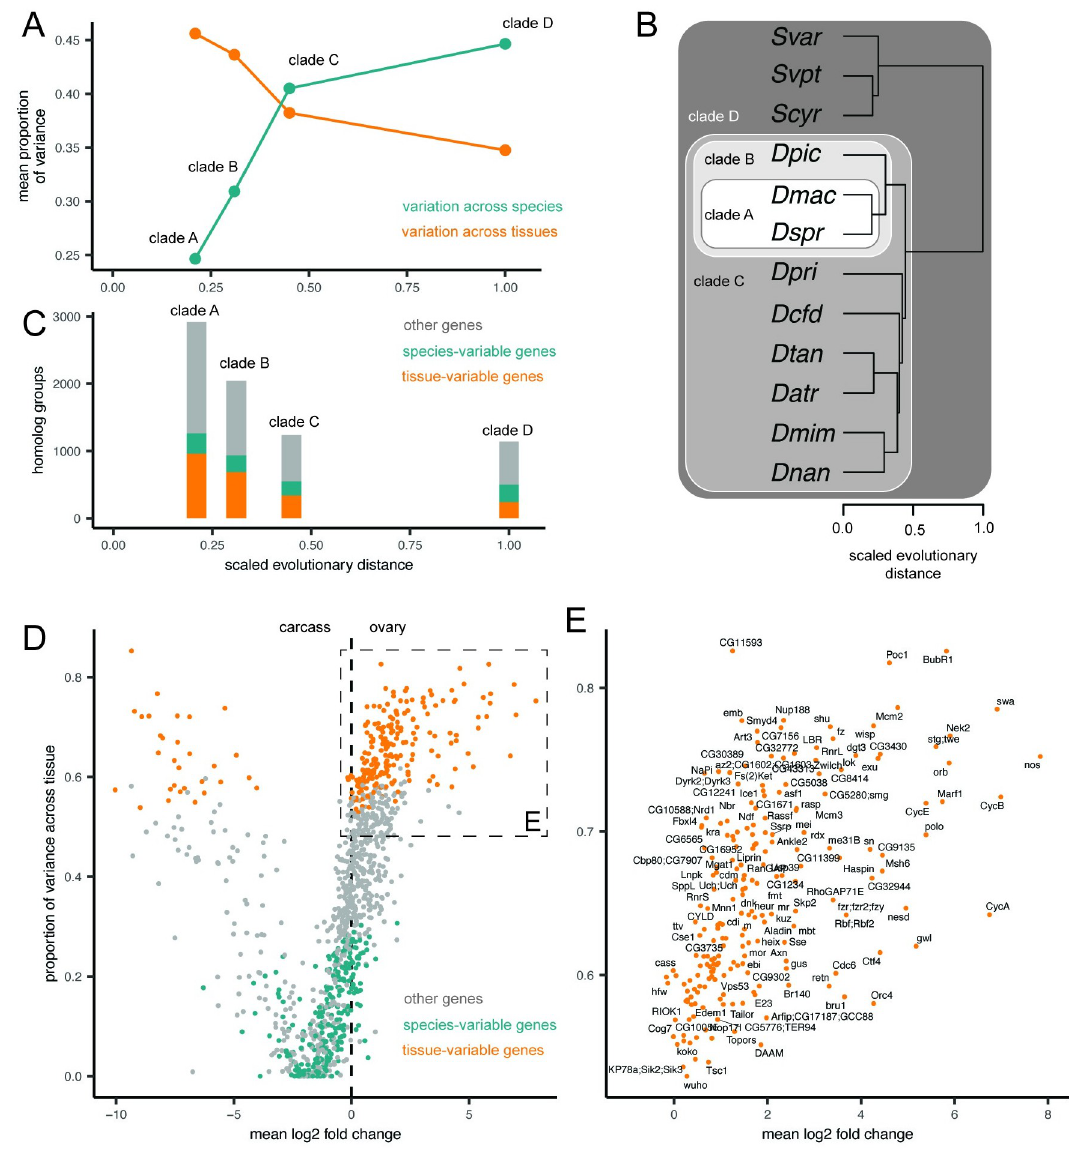
Fig 3. Linear modeling shows the proportion of variance explained by differences across tissues and species. A, The results of a linear modeling approach to calculate expression variation for each gene, attributed to variation across organs, species, or residual variation, as described in Breschi and colleagues (2016) [21]. The average proportion of variation attributed to tissues is higher than that attributed to species for the two picture-wing species in clade A, while the opposite is true for all twelve species in clade D. Sample sizes are for clade A: 2,918 homology groups, clade B: 2,044, clade C: 1,239, and clade D: 1,143. B, The number of genes, defined by homology group, classified as tissue variable genes (TVGs), species variable genes (SVGs), or neither in each clade comparison. C, The phylogeny of the twelve species studied here, showing the four clades compared in A-B. Scaled evolutionary distance is calculated as the relative distance from the most recent common ancestor of Hawaiian drosophilids to extant species. D, Comparing results of the differential gene expression approach (log 2 fold change) on the x-axis to results of the modeling approach on the y-axis (variation across tissues). Genes are colored according to TVGs and SVGs. The inset box highlights TVGs that are upregulated in the ovary relative to the carcass. E, The same plot, now showing only upregulated TVGs, annotated with the gene symbol from the D. melanogaster sequences in the same homology